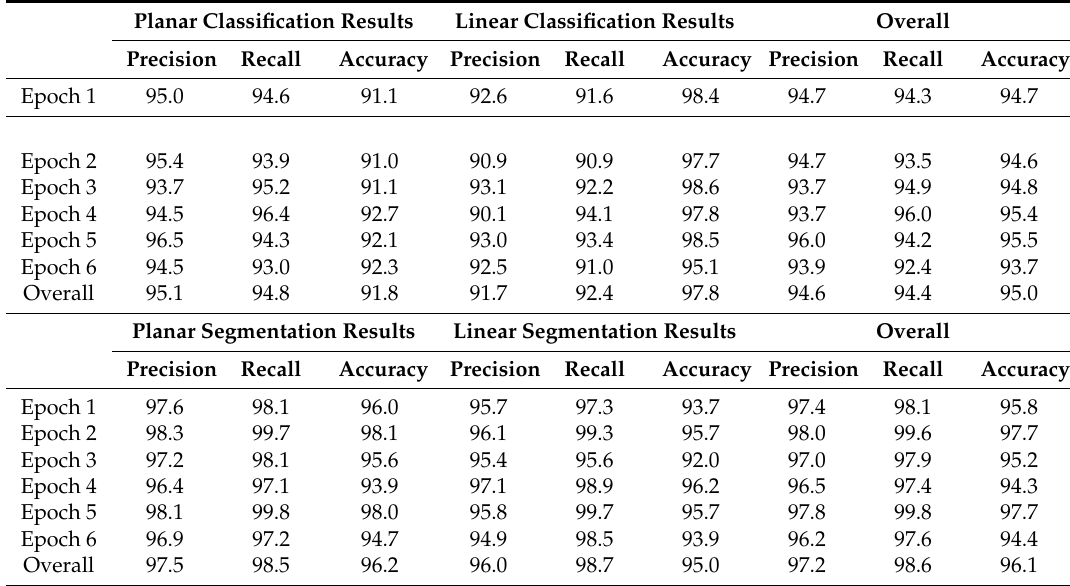
Table 2. Summary of the planar and linear classification and segmentation